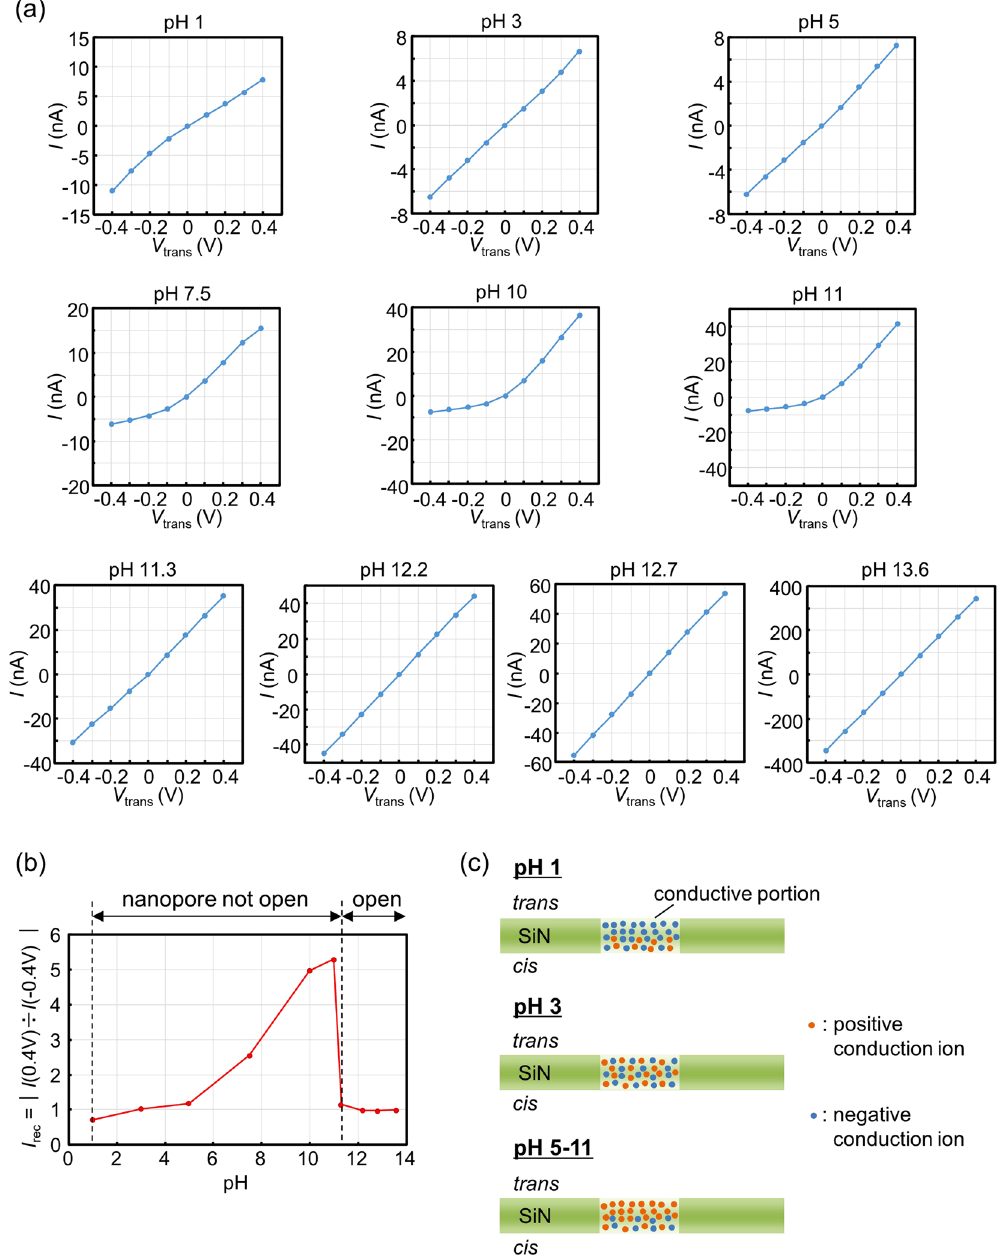
Figure 3. I - V characteristics of membranes after CBD under various pH conditions. ( a ) I - V characteristics of 20-nm-thick SiN membranes after CBD under ten different pH conditions. V cis was set at 0 V during the measurements of the I-V curves. During CBD, V cis and V trans were set at 20 V and 0 V, respectively, and I cutoff was set at 1 μ A. ( b ) Dependence of I rec on pH. ( c ) Schematic illustration of conduction-ion distribution in a conductive-film portion at each pH without voltage